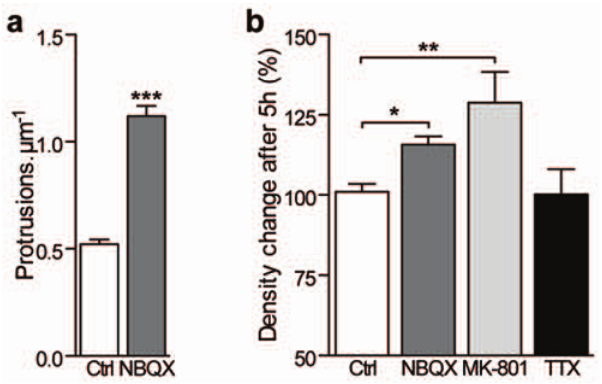
Figure 7. Selective blockade of ionotropic glutamatergic receptors induce an increase in protrusion density. ( a ) In vivo , intraperitoneal injections of NBQX (30 mg/kg) at PND 15 induced a highly significant increase in protrusion density within 5 hours ( n =617 spines from 3 animals in the control group and 472 spines from 6 animals in the NBQX group). ( b ) Effects of a 5 h bath incubation of NBQX (20 m M, n =192 spines in 4 cultures), MK-801 (100 m M, n =409 protrusions in 8 cultures), or TTX (1 m M, n =249 protrusions in 5 cultures) on protrusion density compared to control conditions in hippocampal slice cultures ( n =537 protrusions in 10 cultures). (a, b): ***: P , 0.001, **: P , 0.01, *: P , 0.05, unpaired t test.